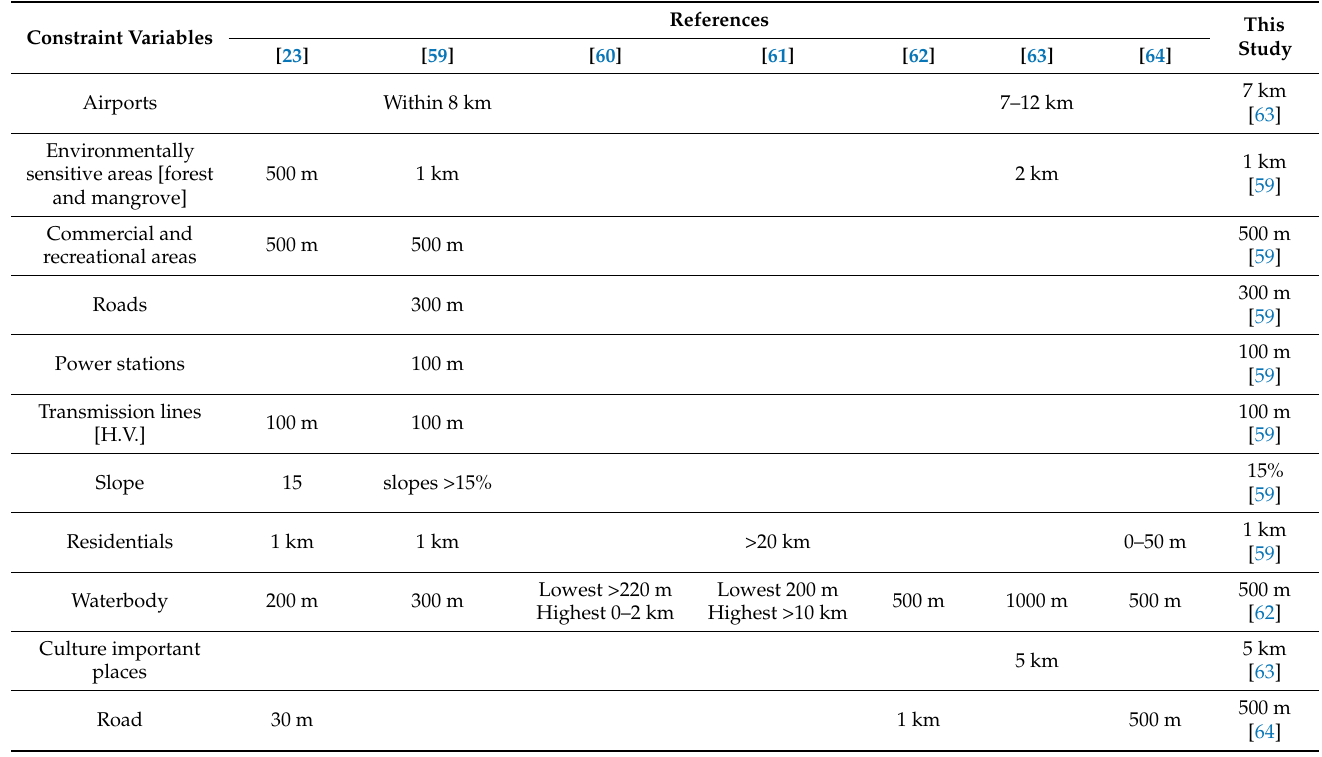
Table A3. The Criteria of Constraint Variables and Buffer Distance.